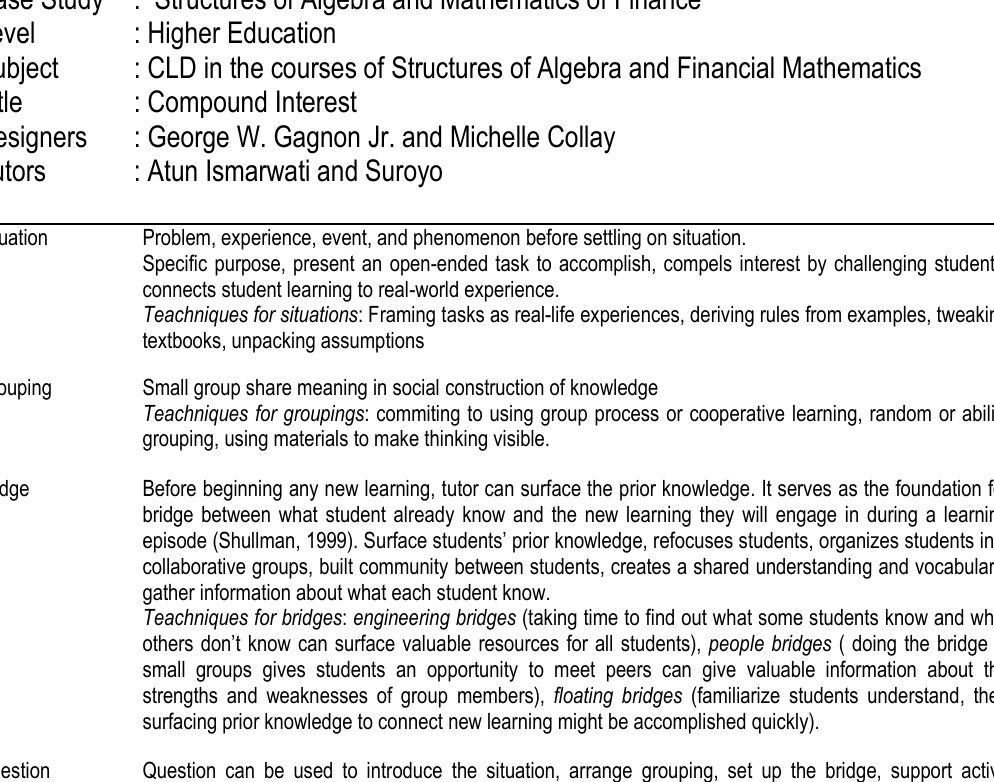
Table 1. Summarizing of CDL Concepts Case